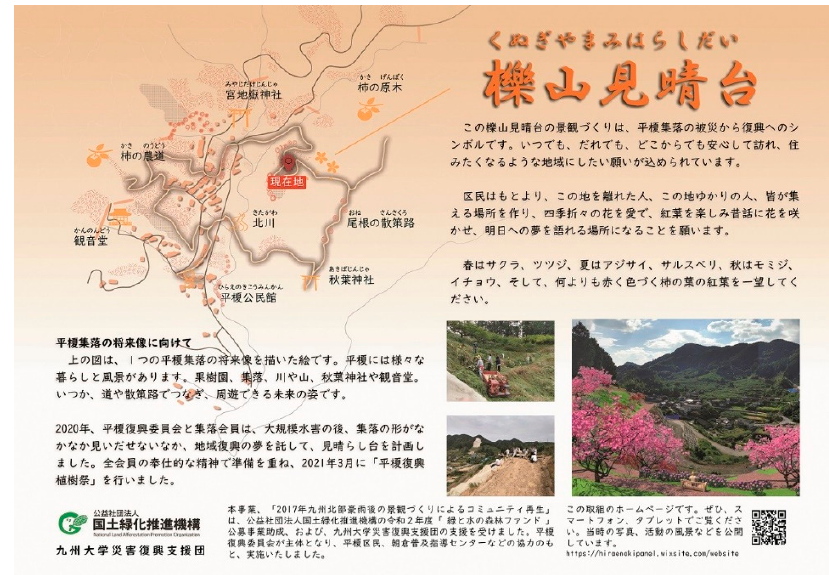
Figure 5. Panel installed at Kunugiyama observation site (created by Kazuo Asahiro [the fourth author]). The panel shows the community residents’ thoughts on the Kunugiyama observation as a symbol of reconstruction and their vision of the future of the Hiraenoki community. It also includes a link to a website that introduces the Kunugiyama observation project with a message from HRC and community residents. Please access the website on your smartphone or tablet. Photos from those days, activity scenes, etc. are